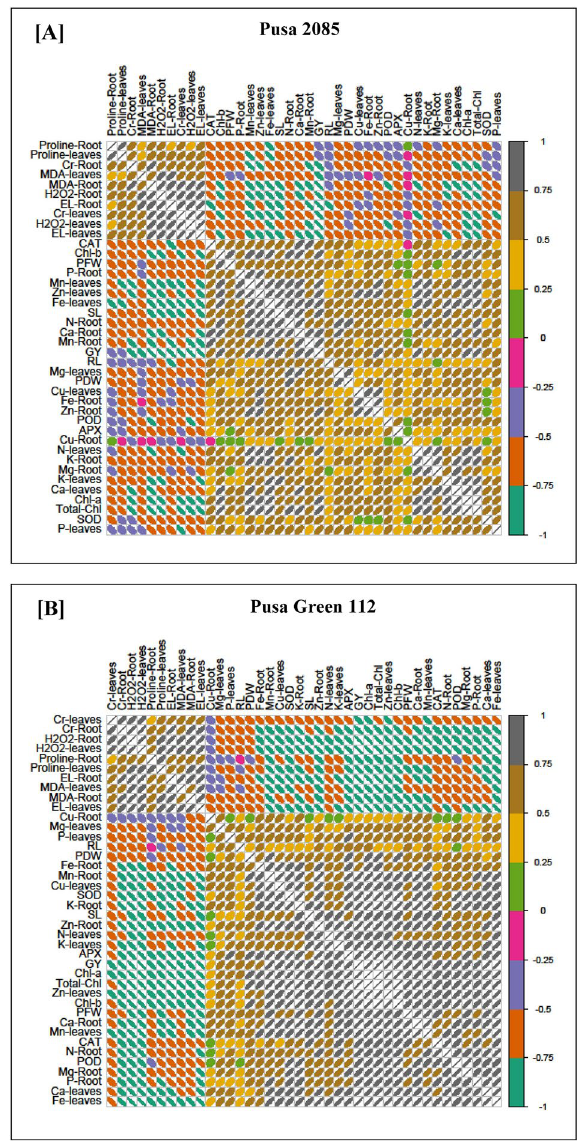
Figure 9. Pearson’s correlation analysis between Cr uptake in the roots and leaves of the chickpea cultivars ( A ) Pusa 2085 and ( B ) Pusa Green 112 and some selected different morpho-physiological attributes, chlorophyll contents, stress biomarkers, enzyme activities, nutrient uptake, and proline contents at 42 days after sowing (grown in pots). The various attributes used in the figures are as follows: Cr-leaves, Cr-Root, H 2 O 2 -Root, H 2 O 2 -leaves, Proline-Root, Proline-leaves, EL-Root, MDA-leaves, MDA-Root, EL-leaves, Cu-Root, Mg-leaves, P-leaves, RL-Root length, PDW-Plant dry weight, Fe-Root, Mn-Root, Cu-leaves, SOD-superoxide dismutase, K-Root, SL-Shoot length, Zn-Root, N-leaves, K-leaves, APX-ascorbate peroxidase, GY-Grain yield, Chl- a , total chlorophyll, Zn-leaves, Chl- b , PFW-Plant fresh weight, Ca-Root, Mn-leaves, CAT-Catalase, N-Root, POD- Peroxidase, Mg-Root, P-Root, Ca-leaves, and